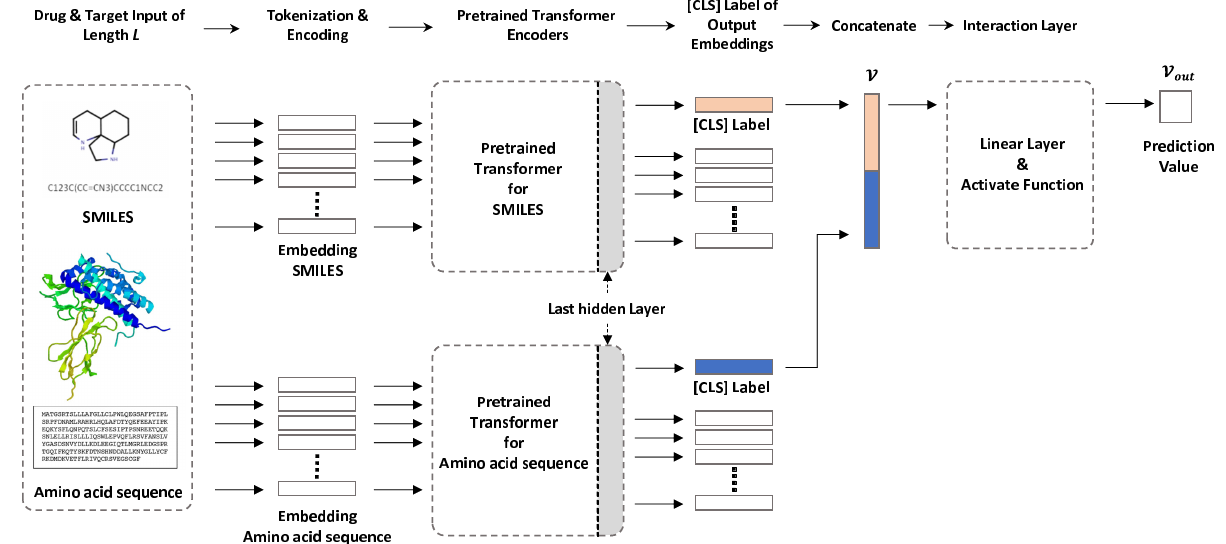
Figure 1. Our model configuration. The sequence information of compounds and proteins is captured as a [CLS] vector of the last hidden layer in each pretrained transformer. Each piece of captured sequence information is concatenated and input to the interaction layer, and the DTI prediction value is